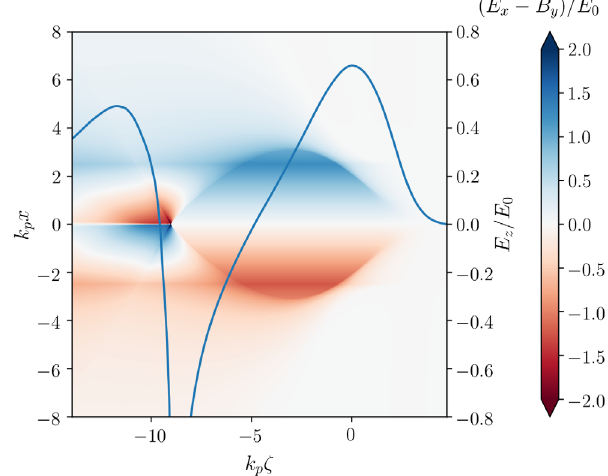
FIG. 2. 2D map of the transverse wakefield ð E x − B y Þ =E 0 and on-axis line-out of E z =E 0 (blue curve) generated by an electron drive beam in a finite plasma column with radius k p R p ¼ 2 . 5 . Drive beam parameters are the same as in Fig. 1. The finite k R ¼ 2 . 5 . plasma column leads to the formation of a wide longitudinal p p region that is both accelerating and focusing for positron